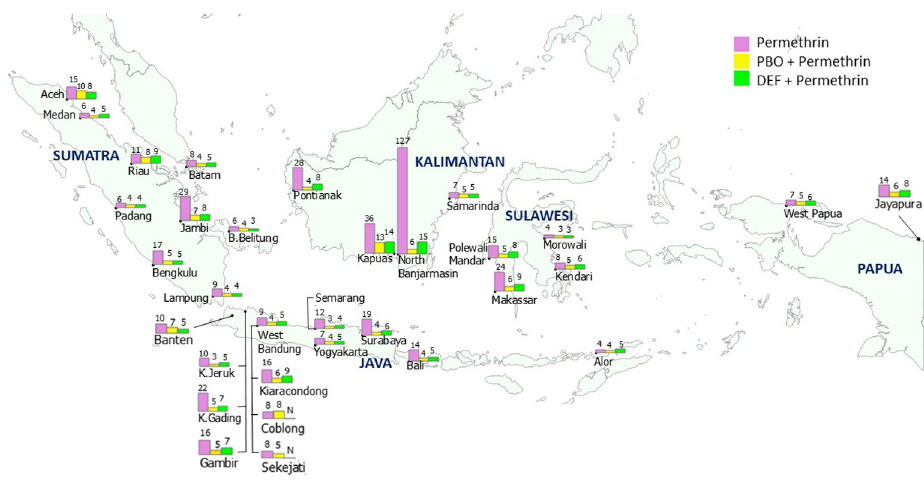
Fig 4. Map of RR 50 of Ae . aegypti field strains to permethrin with and without synergists. Map base layer was obtained from https://www.naturalearthdata.com/. Map base layer was modified in QGIS software version 3.4 Madeira. Note: The number above each bar represents RR 50 , which was calculated relative to the susceptible reference strain (Bora-Bora; N indicates lack of available data).